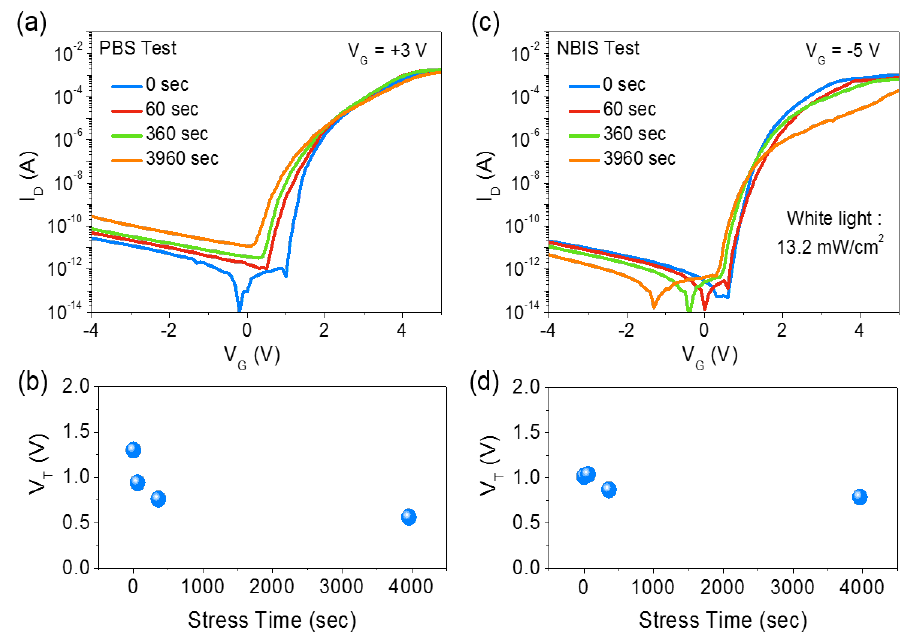
Figure 5. ( a ) Positive gate bias stability and ( b ) evolution of threshold voltage (V T ) of solution-processed InO x TFTs with the 150 °C-annealed HGD dielectric layer (V GS = +3 V, t = 3960 s); ( c ) negative gate bias illumination stability and ( d ) evolution of threshold voltage (V T ) of solution-processed InO x TFTs with the 150 °C-annealed HGD dielectric layer (V GS = −5 V, t = 3960 s).